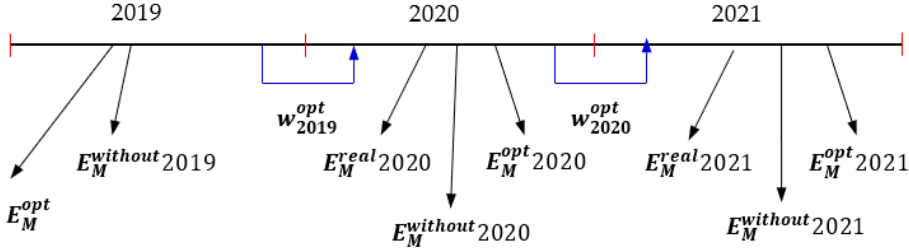
Figure 8. Evaluation of the different categories of income for a historical period of one year.